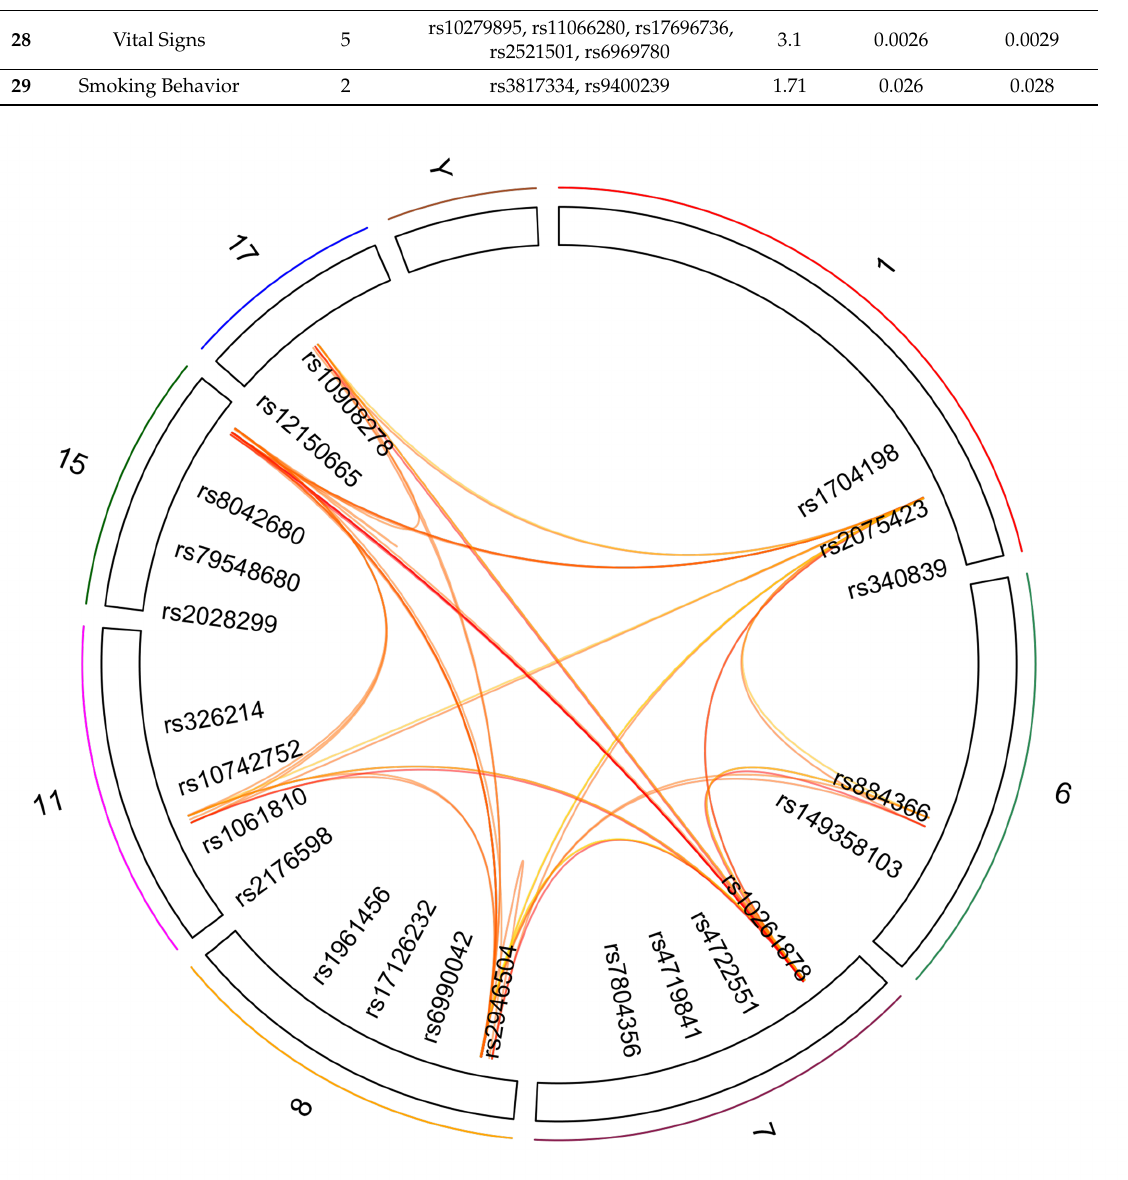
Figure 3. SNP-based Similarity Analysis of the identified SNPs using the “Socialiser for SNPs” option in the eXploring Genomic Relations (XGR) web tool. Seven SNPs showed similarity to at least 10 other SNPs with a similarity score of more than 0.5 in scale range from 0 to